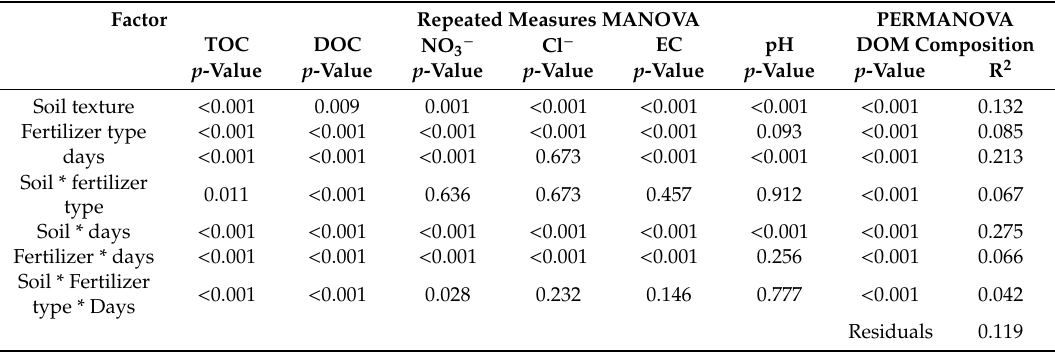
Table 1. Statistical results testing the e ff ects of soil texture (soil), fertilizer type and time (days) on the concentration of leached nutrients (TOC, DOC, NO 3 − ) as well as on the optical properties of the leached organic matter (DOM composition) by using repeated measures MANOVA and permutational MANOVA (PERMANOVA) are given. Interaction between factors are marked with